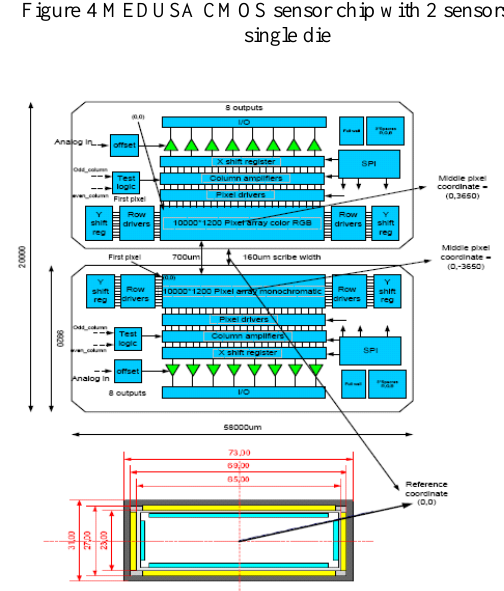
Figure 5 schematic layout of the MEDUSA CMOS sensor with the 2 independent sensors on one single chip